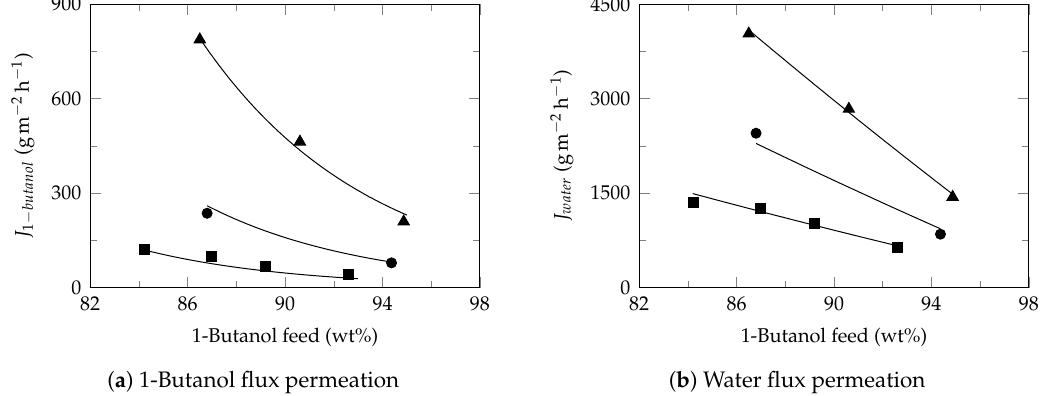
pressure: 500Pa, Table 4.